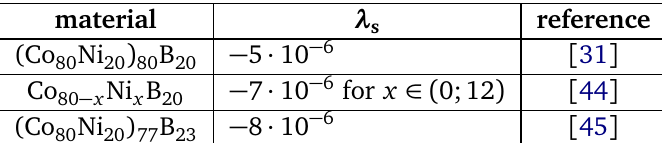
for some Co-rich CoNiB compounds. s